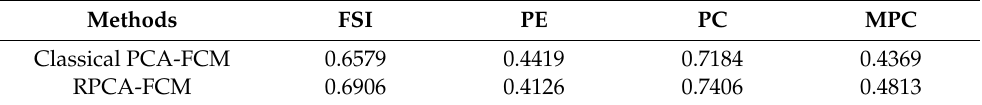
Table 9. Validity measures of the statistical models for the simulation data.